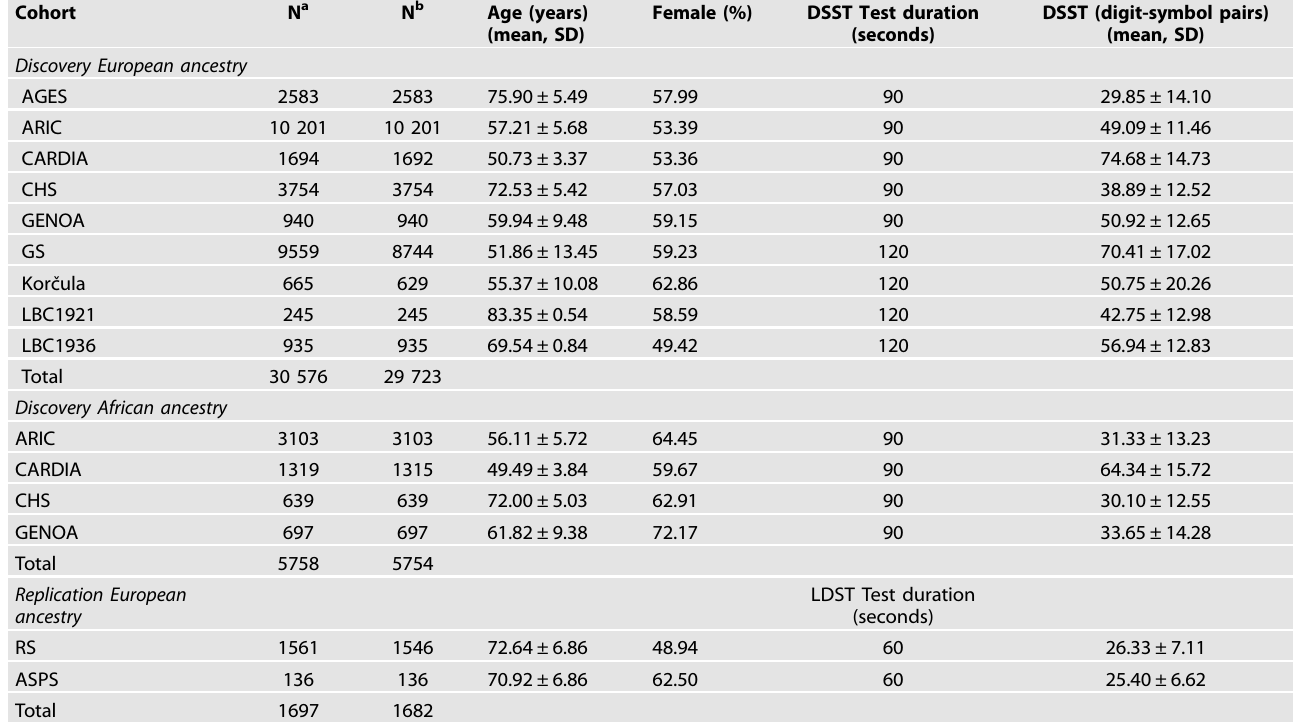
Table 1. Discovery and replication cohorts.